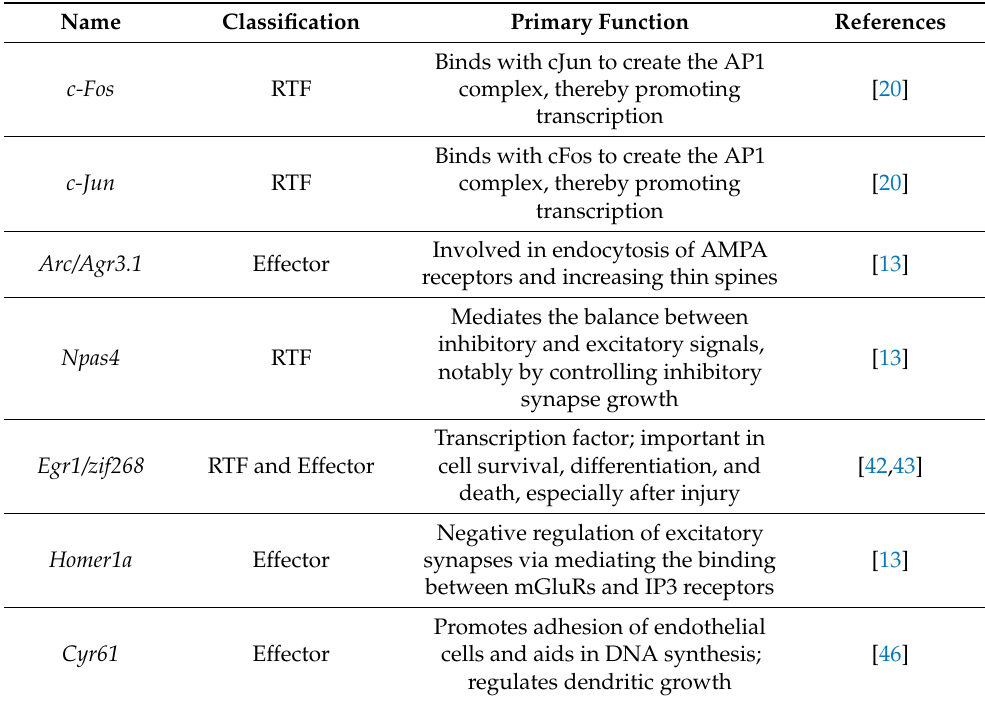
Table 1. Selection of IEGs and their known primary function in synaptic